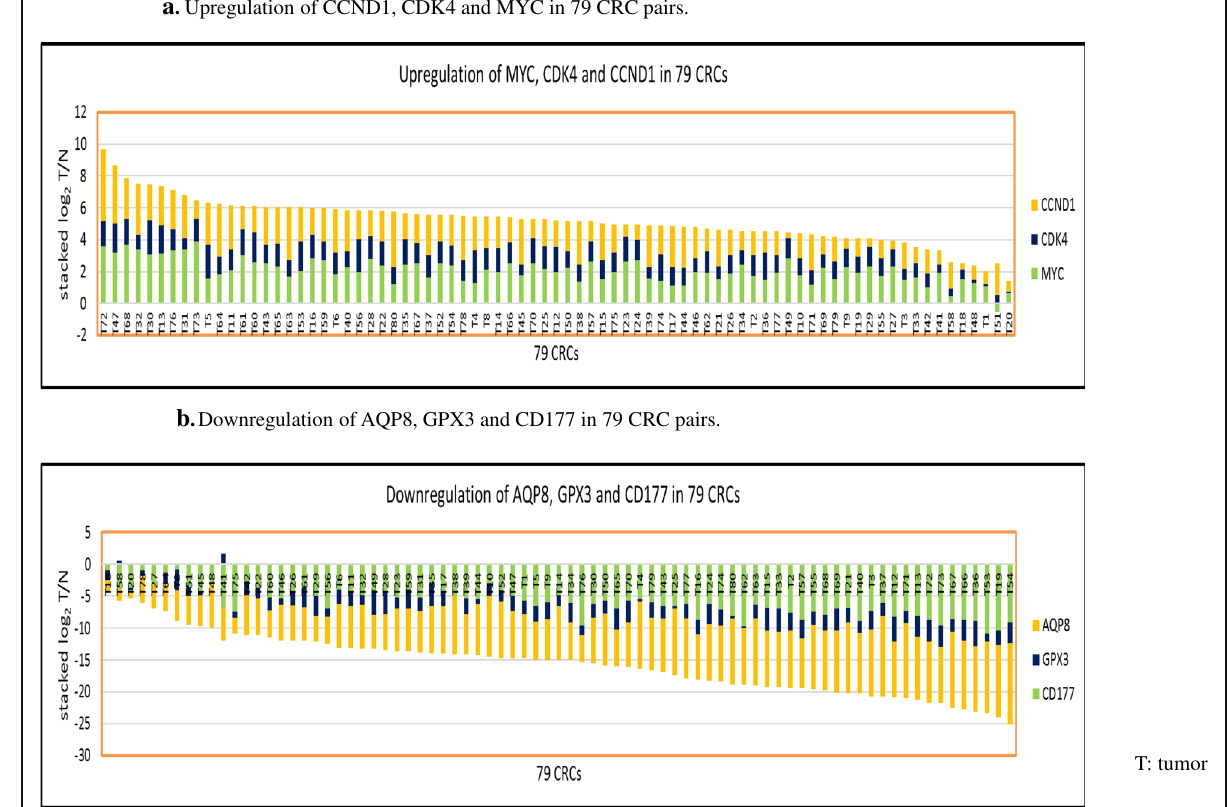
Fig. 1 NGS analysis of 6 cancer hallmark gene expression in 79 CRC pairs. a . Upregulation of CCND1, CDK4 and MYC in 79 CRCs. b . Downregulation of AQP8, GPX3 and CD177 in 79